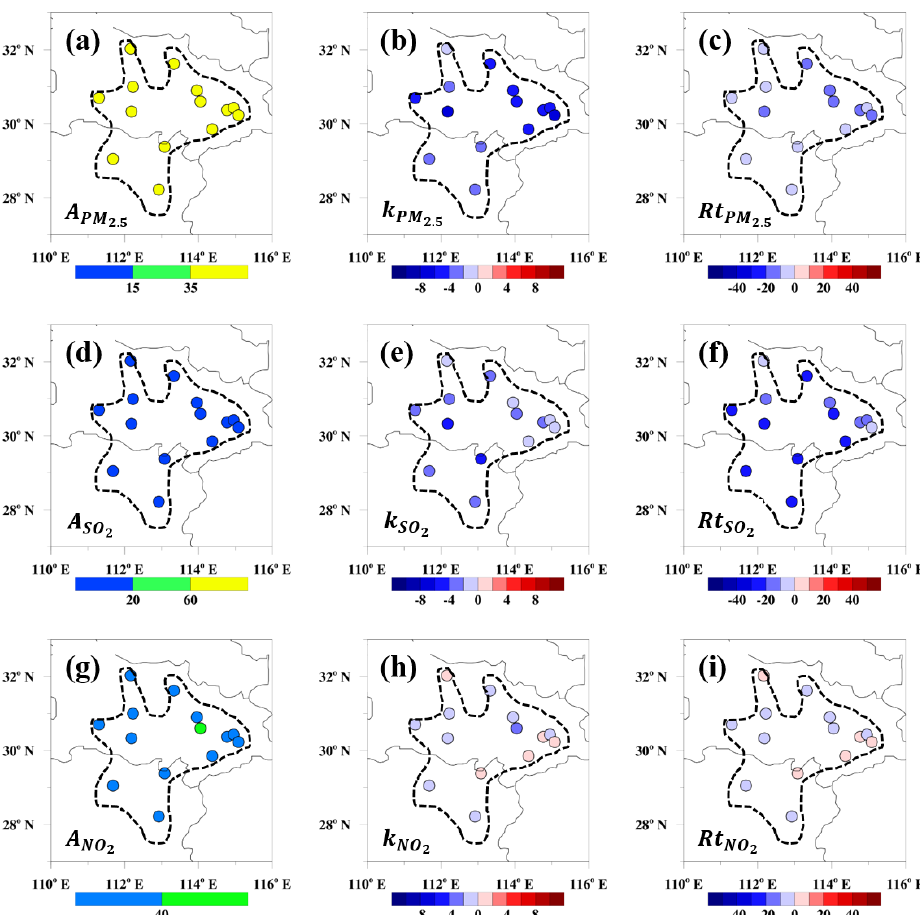
Figure 5. Spatial distributions of (a, d, g) 5-year averages of (a) PM 2 . 5 , (d) SO 2 and (g) NO 2 concentrations ( A , unit: µgm − 3 ), (b, e, h) the linear trends in interannual variations of (b) PM 2 . 5 , (e) SO 2 and (h) NO 2 ( k , unit: µgm − 3 yr − 1 ), as well as (c, f, i) the change rates (Rt = k/A , unit: %yr − 1 ) of (c) PM 2 . 5 , (f) SO 2 and (i) NO 2 in the THB over